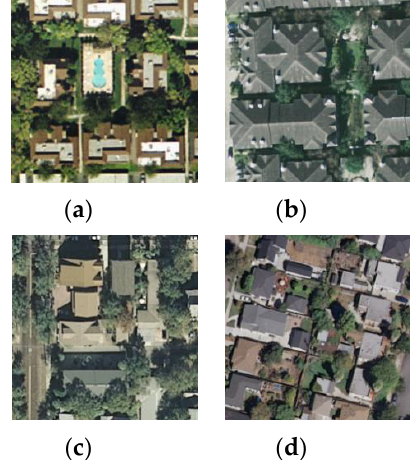
Figure 9. Class representatives of the UC Merced LandUse dataset: ( a ) dense residential; ( b ) dense residential; ( c ) medium residential; ( d ) medium residential.